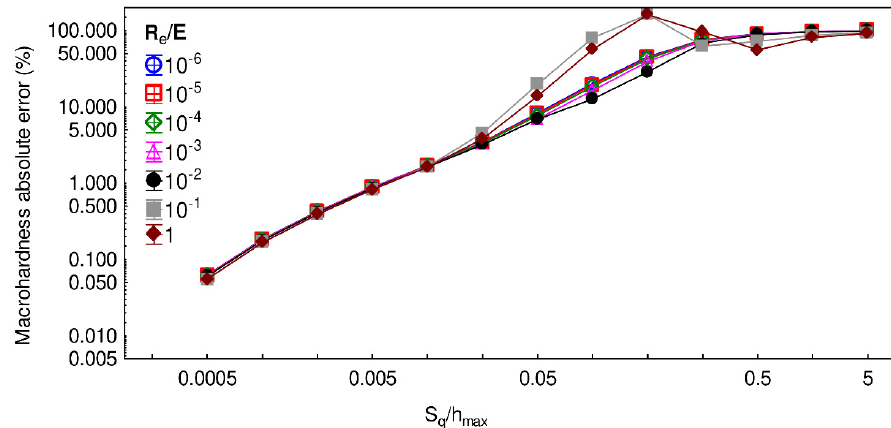
Figure 10. Macrohardness absolute error as a function of the ratio S q /h max for different values of R e /E ratio. The mesh size, wavelength, and fractal dimension were, respectively, set to 256 × 256, 32 µm, and 2.5.